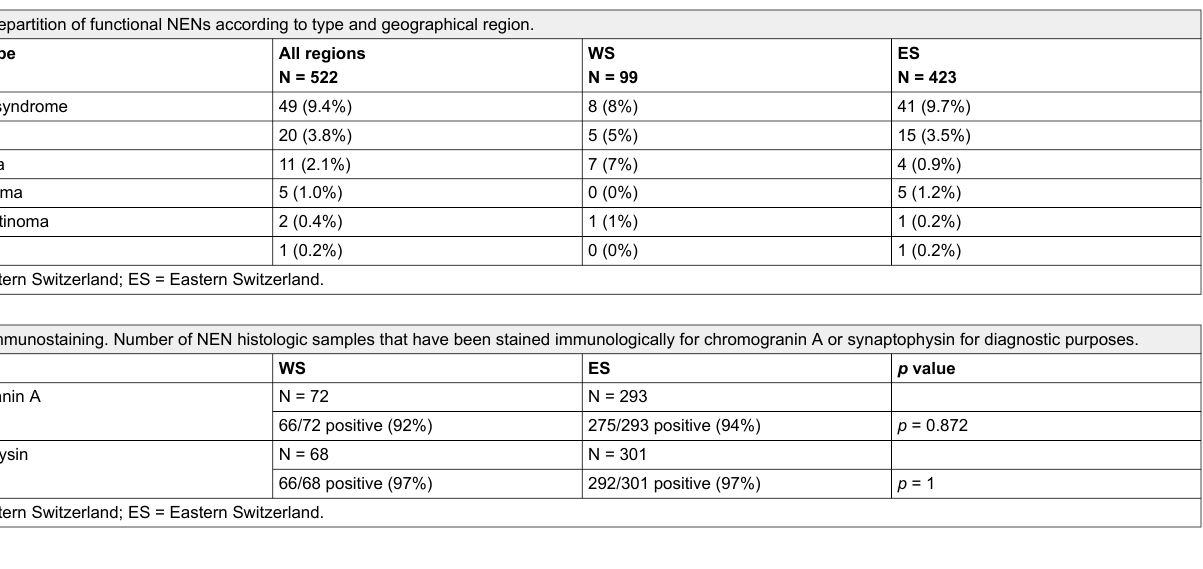
First line therapy in WS and ES. WS = Western Switzerland; ES = Eastern Switzerland.